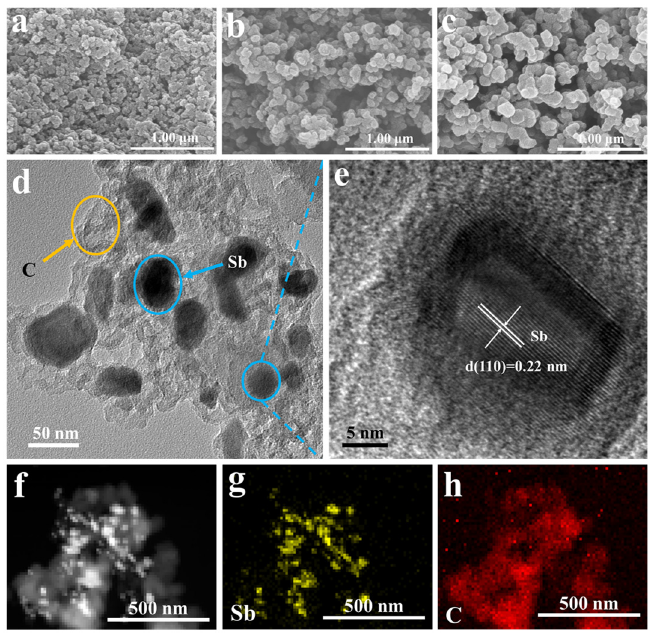
Figure 2. ( a – c ) SEM images of the 3DPNS-Sb/C-1, 3DPNS-Sb/C-2 and 3DPNS-Sb/C-3 composites, ( d , e ) TEM and HRTEM images of the 3DPNS-Sb/C-2 composites, ( f ) STEM image, ( g ) Sb and ( h ) C element mappings of the 3DPNS-Sb/C-2